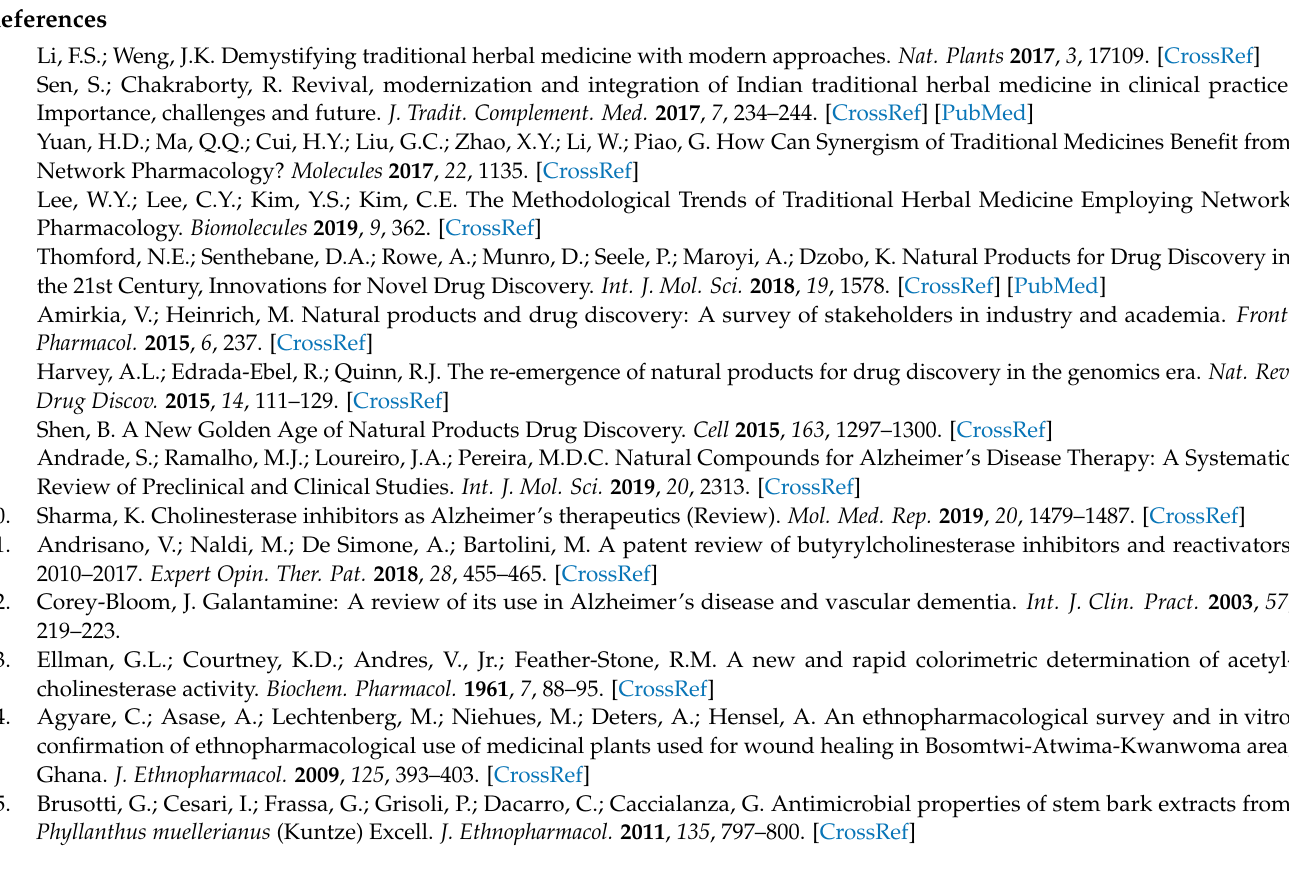
Figure S1: Chromatographic profiles of fractions PMWE, PMME and dPMME, Figure S2: Chro- matographic profiles of dPMME and its water-soluble and insoluble fractions, Figure S3: 1 H-NMR spectrum of PC1 extract, identified as